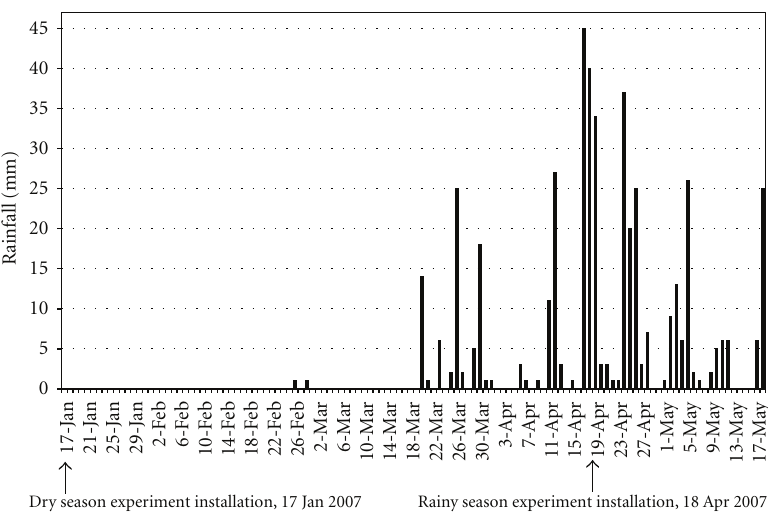
Figure 1: Rainfall at the experiment site, Kenya Agricultural Research Institute. Dry season experiment duration: 17 January to 01 June 2007. Rainy season experiment duration: 18 April to 18 May